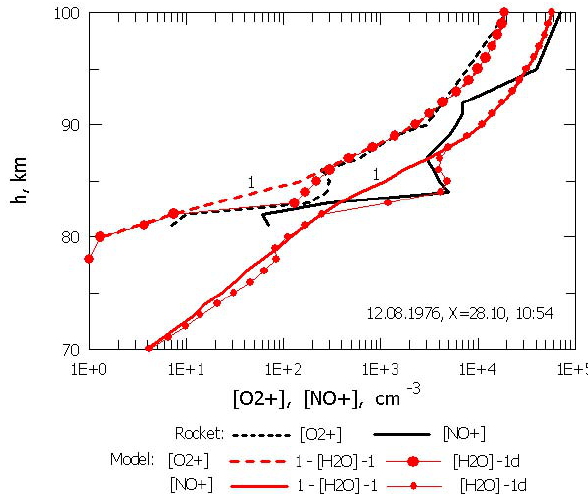
Fig. 9. Number density profiles for the NO + and O + molecular 2 ions calculated for 12 August 1976 at 10:54LT, with a solar zenith angle of 28.10 ◦ using the H 2 O-1 (red lines without symbols) and H 2 O-1d (red lines with symbols) profiles. The black lines represent NO + (solid) and O + (dashed) profiles measured by Kopp and Her- 2 rmann (1984).